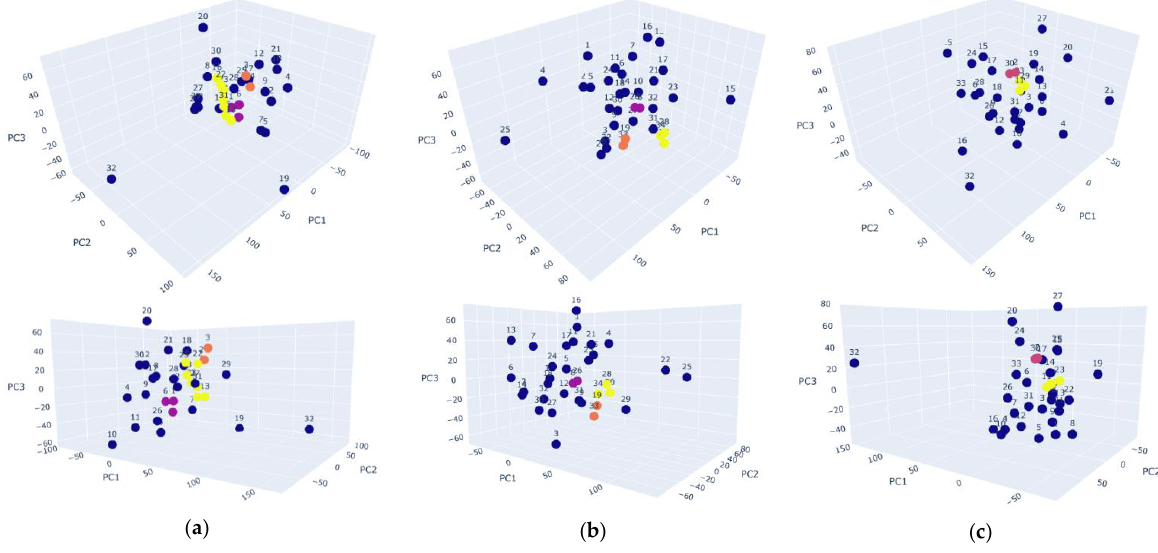
Figure A3. A series of differing perspectives for the PCA analysis of Figure 7): ( a ) P Max -Aluminum; ( b ) P Min -Aluminum; and ( c ) P Med -Aluminum.